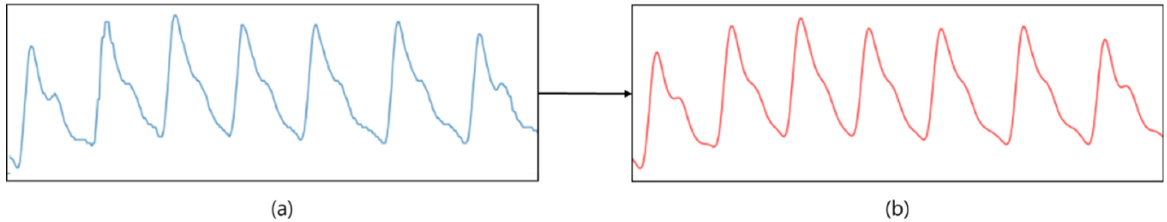
Figure 3. cPPG signal denoising using FIR filter: ( a ) before; ( b ) after. rPPG